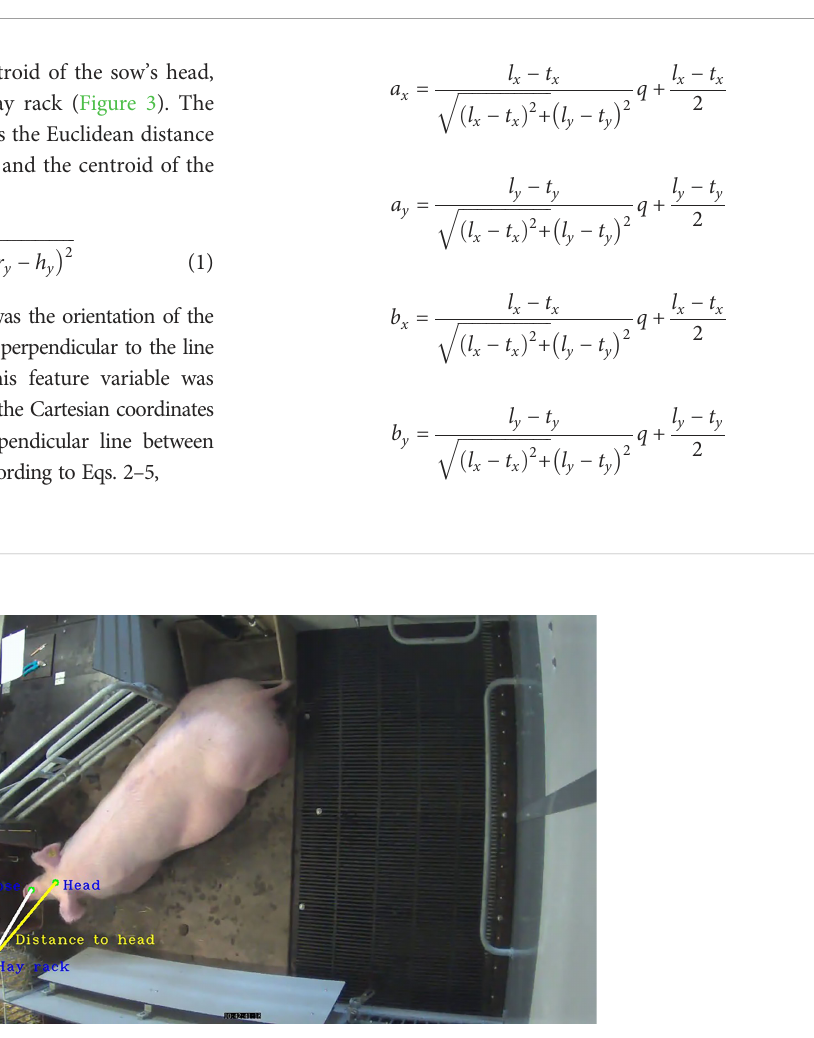
FIGURE 2 Output of the RetinaNet algorithm; centroids extracted from parts of the body of a sow and a hay